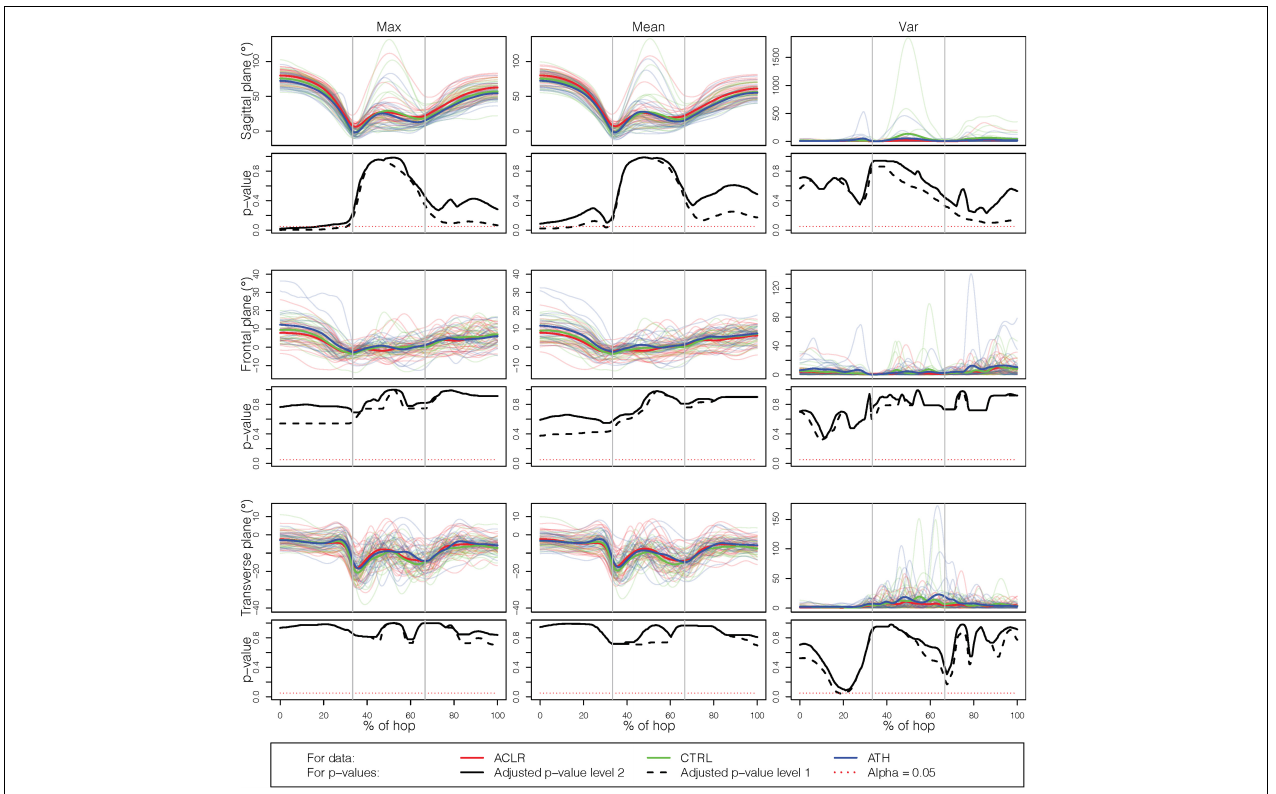
FIGURE 5 | Results for the single knee joint, comparing the injured leg with the dominant leg. The rows correspond to the three planes (sagittal, frontal, and transverse) while the columns correspond to the different outcome measures (Max, Mean, and Var).